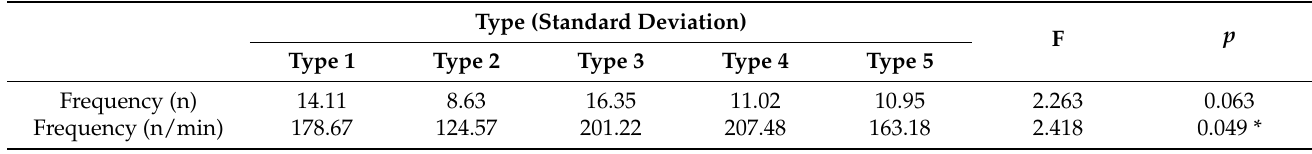
Table 23. Homogeneous variance analysis of key saccade data of different sizes.